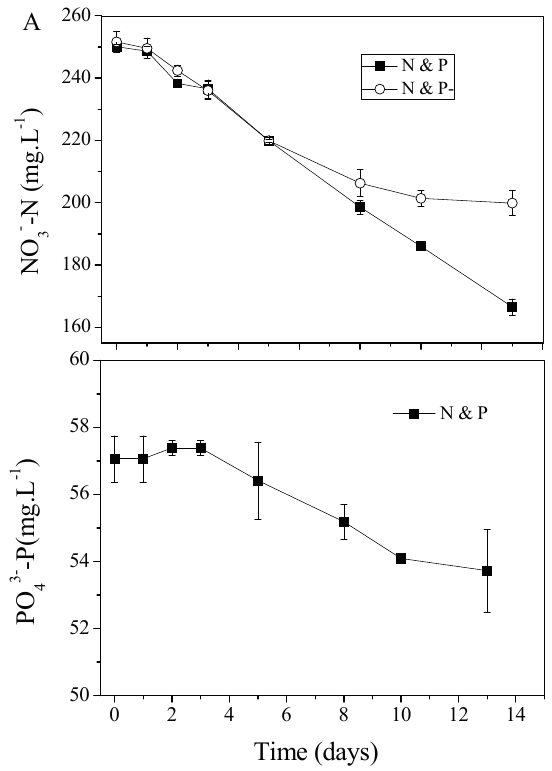
Figure 2. Profiles of ( A ) nitrogen (NO 3 − -N) and ( B ) orthophosphate (PO 43 − -P) assimilation by C. vulgaris cultured in different conditions. Values shown are averages of two samples ±